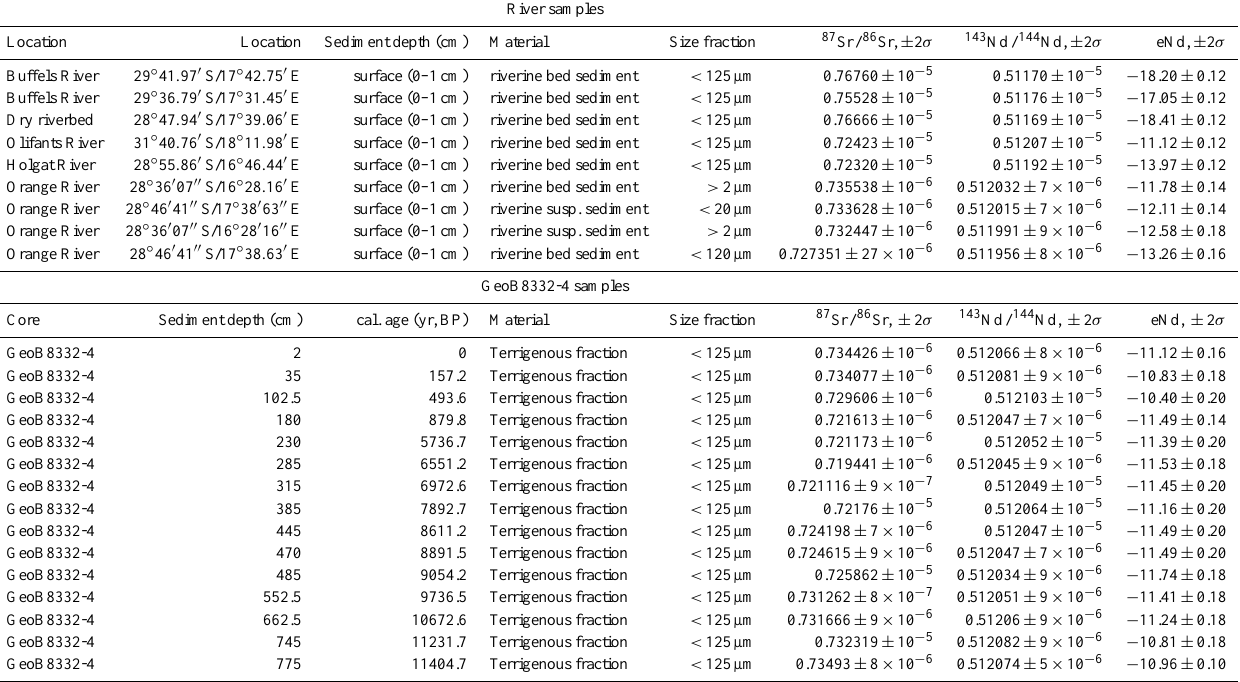
Table 2. Results of Sr and Nd isotope analysis in river and marine core